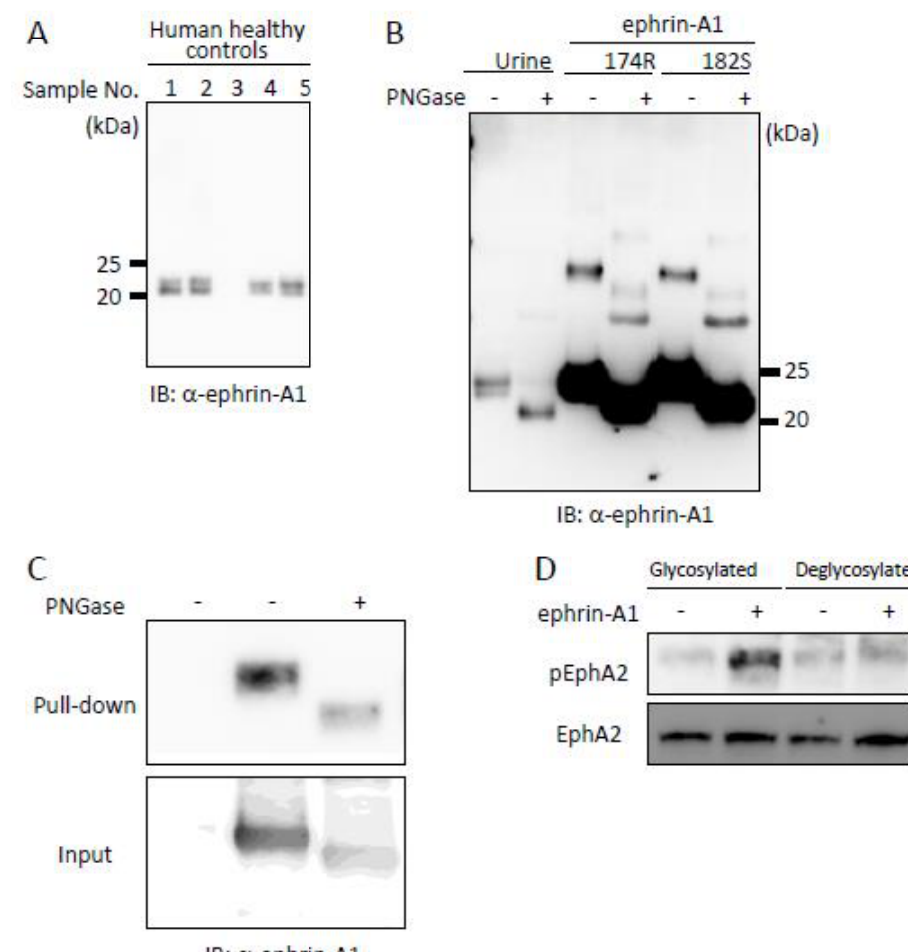
Figure 5. Effects of glycosylation of ephrin-A1 on the receptor activation. ( A ) Ephrin-A1 in urine of human healthy controls. Fifty-fold times concentrated human urine was analyzed by immunoblotting using anti-ephrin-A1 monoclonal antibody. Urinary ephrin-A1 was detected. ( B ) Comparison of recombinant human ephrin-A1 produced in HEK293 cells and human urinary ephrin-A1. Ephrin-A1 174R and urinary ephrin-A1 were treated with PNGase and analyzed by immnoblotting. Both were glycosylated due to post-translational modification ( C ) Effect of glycosylation on ephrin-A1 on the receptor binding. Either glycosylated ephrin-A1 or deglycosylated ephrin-A1 was incubated with His-tagged extracellular domain of EphA2. Pull down assay indicated that deglycosylation of ephrin-A1 showed no effect on its receptor binding. ( D ) Effect of glycosylation on the receptor activation. HEK293 cells were stimulated with either glycosylated or deglycosylated ephrin-A1. Deglycosylated ephrin-A1 failed to induce tyrosine phosphorylation of EphA2.